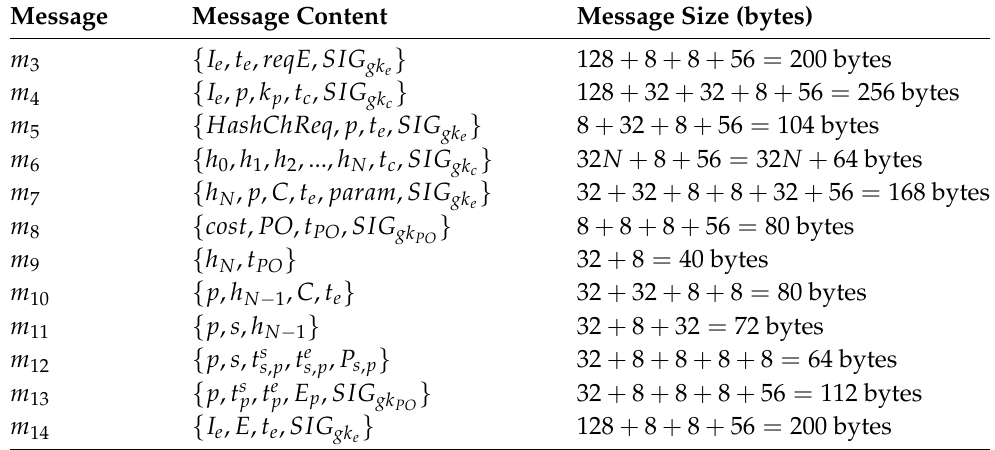
Table 2. Calculation of message sizes for message m 3 to m 14 exchanged during EV registration, authentication, charging activation and